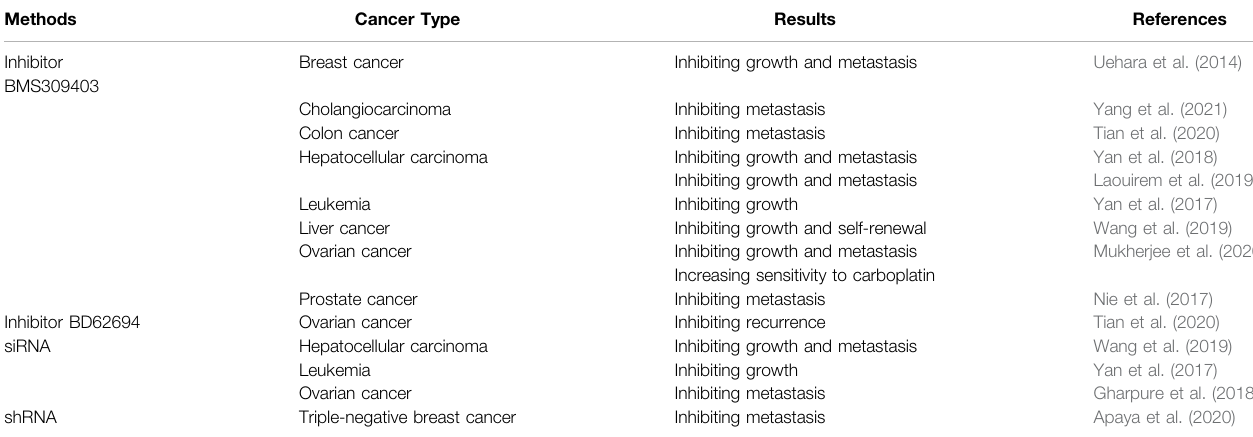
TABLE 2 | Therapeutic targeting of FABP4 evaluated in different cancer